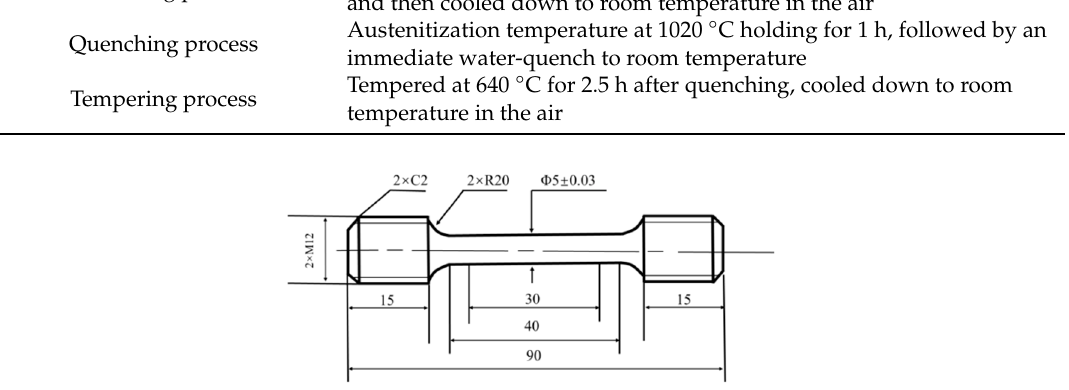
Figure 2. The drawing of high-temperature tensile specimen. (mm) Table 4. Heat treatment process of test steels.